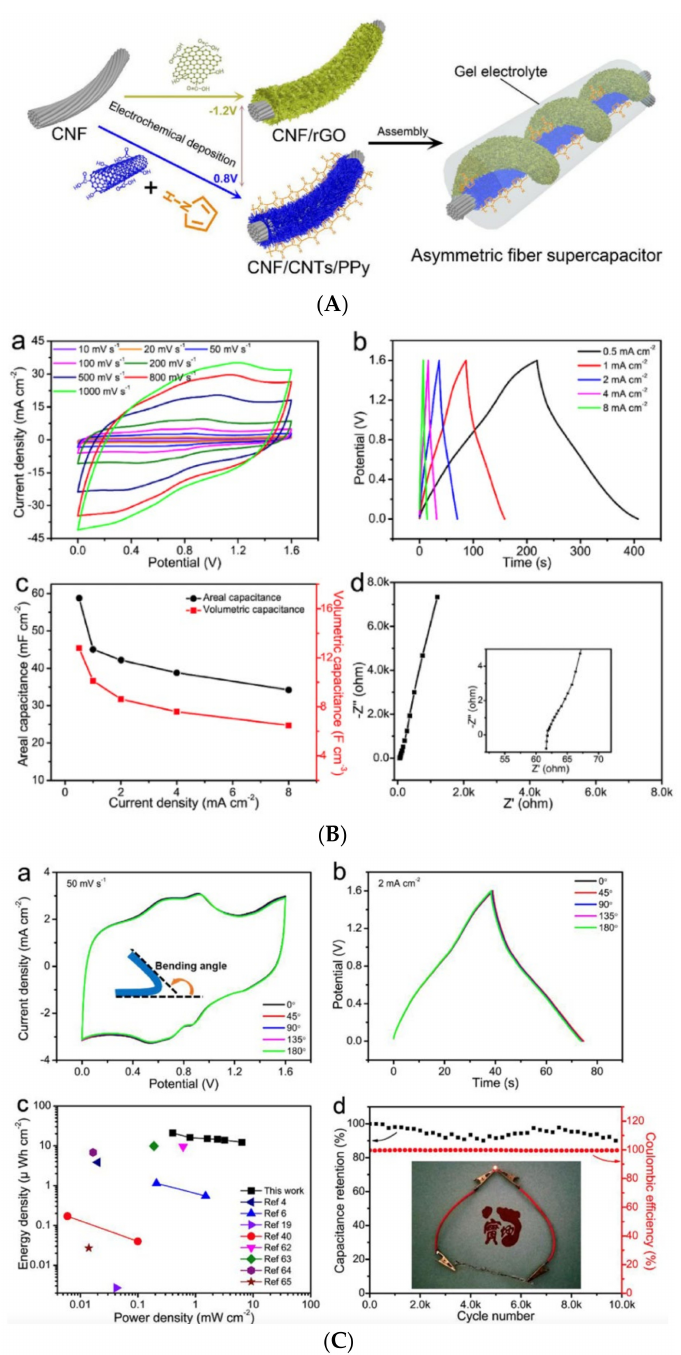
Figure 12. ( A ) Schematic of the fabrication of an FASC. ( B ) Electrochemical performances of FASC: ( a ) CV curves at various scan rates ranging from 10 to 1000 mV · s − 1 ; ( b ) GCD curves at the current densities from 0.5 to 8 mA · cm − 2 ; ( c ) areal and volumetric specific capacitances at various current densities; ( d ) Nyquist plots carried out in a frequency range from 100 kHz to10 MHz. The inset shows the enlarged plot in the high-frequency region ( C ): ( a ) CV curves for the asymmetric capacitor at a scan rate of 50 mV · s − 1 , under different bending states, with the inset showing an illustration of an asymmetric supercapacitor at different bending angles; ( b ) GCD curves at a current density of 2 mA · cm − 2 for the asymmetric supercapacitor under different bending states; ( c ) Ragone plots of the presently and previously reported supercapacitors; ( d ) capacitance retention during 10,000 GCD cycles. The inset shows a LED lit up at 2.4 V by two asymmetric supercapacitors in series. Reprinted with permission from